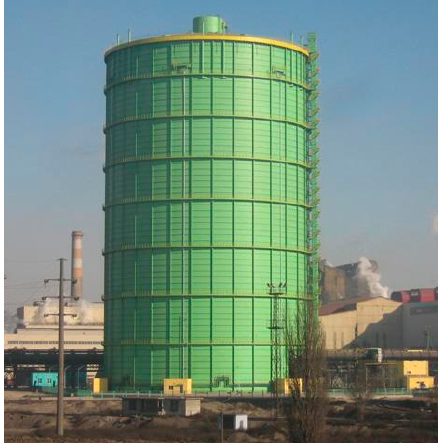
Figure 1. Gasholder used in a practical engineering application.